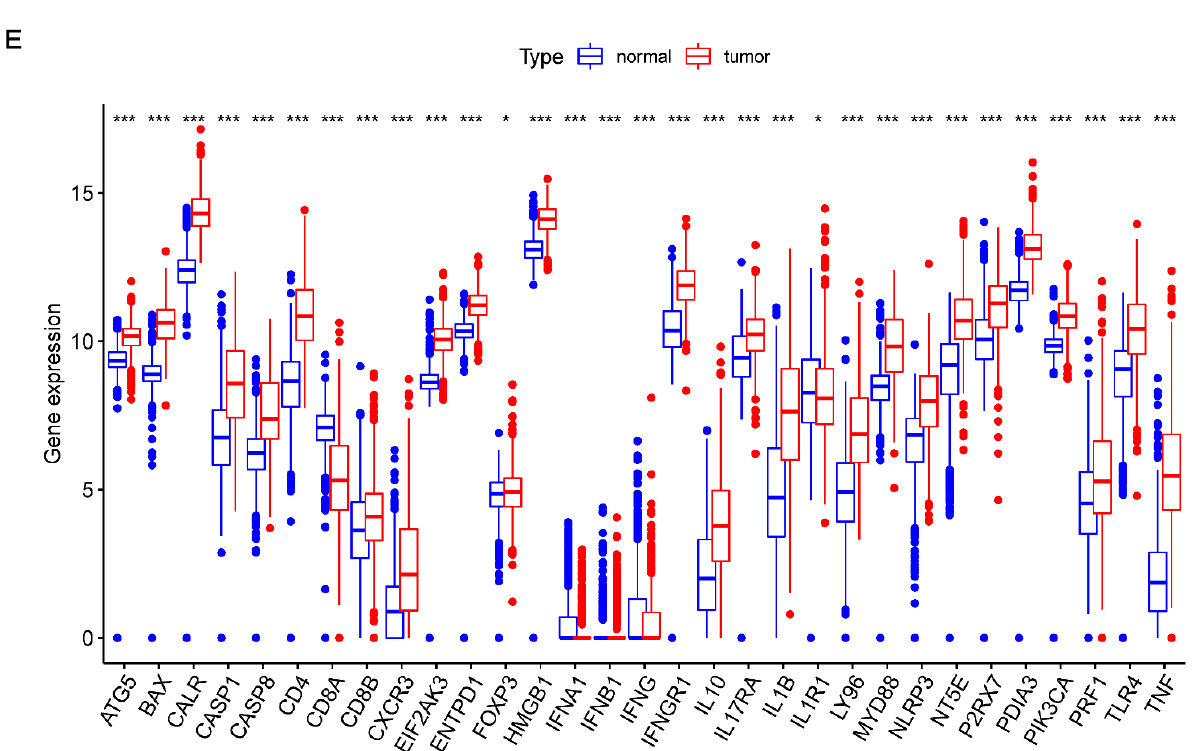
Figure 1. Transcriptional changes in the ICD-related genes of glioma. ( A , B ) Mutation frequencies of 31 ICD-related genes in 523 and 461 patients with LGG and GBM, respectively, from the TCGA database. ( C ) Increase, decrease, and no changes in CNVs among the ICD-related genes. ( D ) Position of ICD-related genes on the 23 pairs of chromosomes. ( E ) Analysis of the expression levels for 31 ICD- related genes between normal and glioma tissues. *, p = 0.01–0.05; ***, p < 0.001; ICD, immunogenic cell death; LGG, lower-grade glioma; GBM, glioblastoma; TCGA, the Cancer Genome Atlas; CNV, copy number